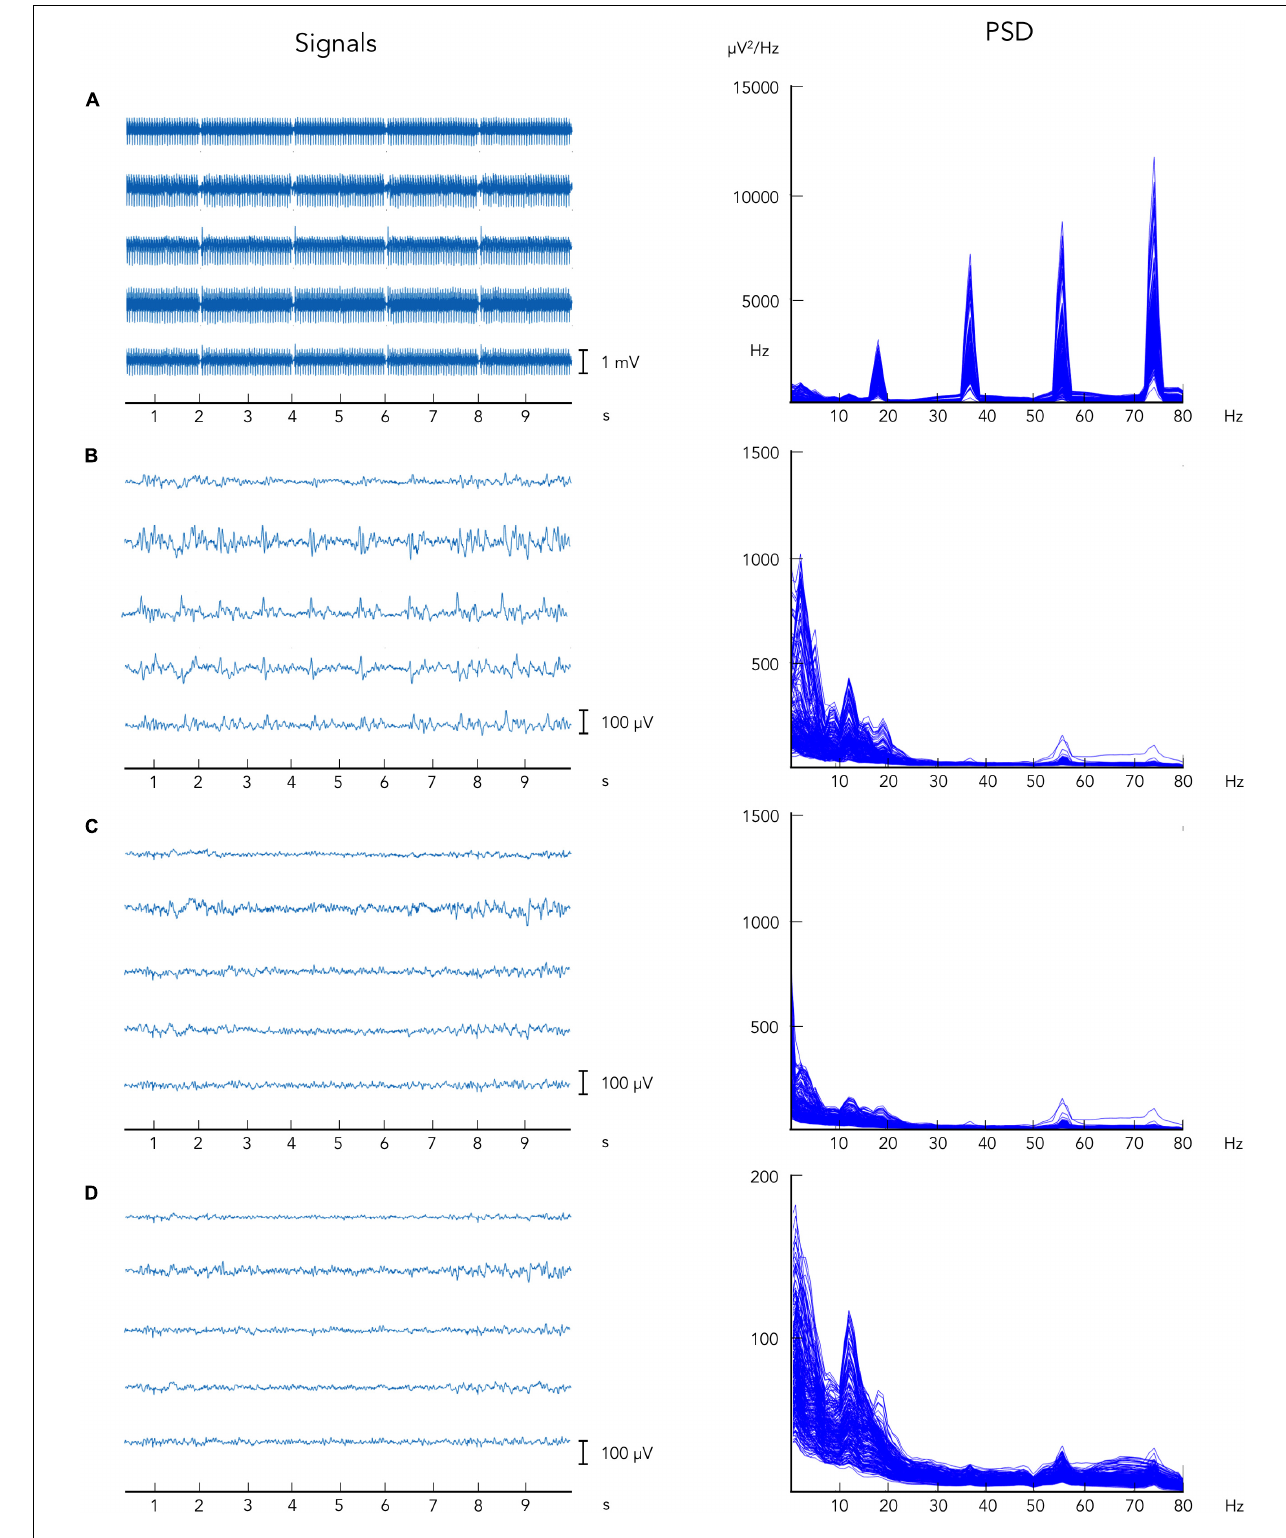
FIGURE 2 | Illustrative example of EEG data collected during simultaneous EEG–fMRI following the artifacts removal steps. EEG data are displayed: (A) before gradient artifact correction, i.e., raw data, (B) after gradient artifact correction, (C) after BCG artifact correction, and (D) after ICA-based artifacts removal. On the left, EEG signals are reported for five representative channels. On the right, power spectrum density is shown for all EEG recording channels.